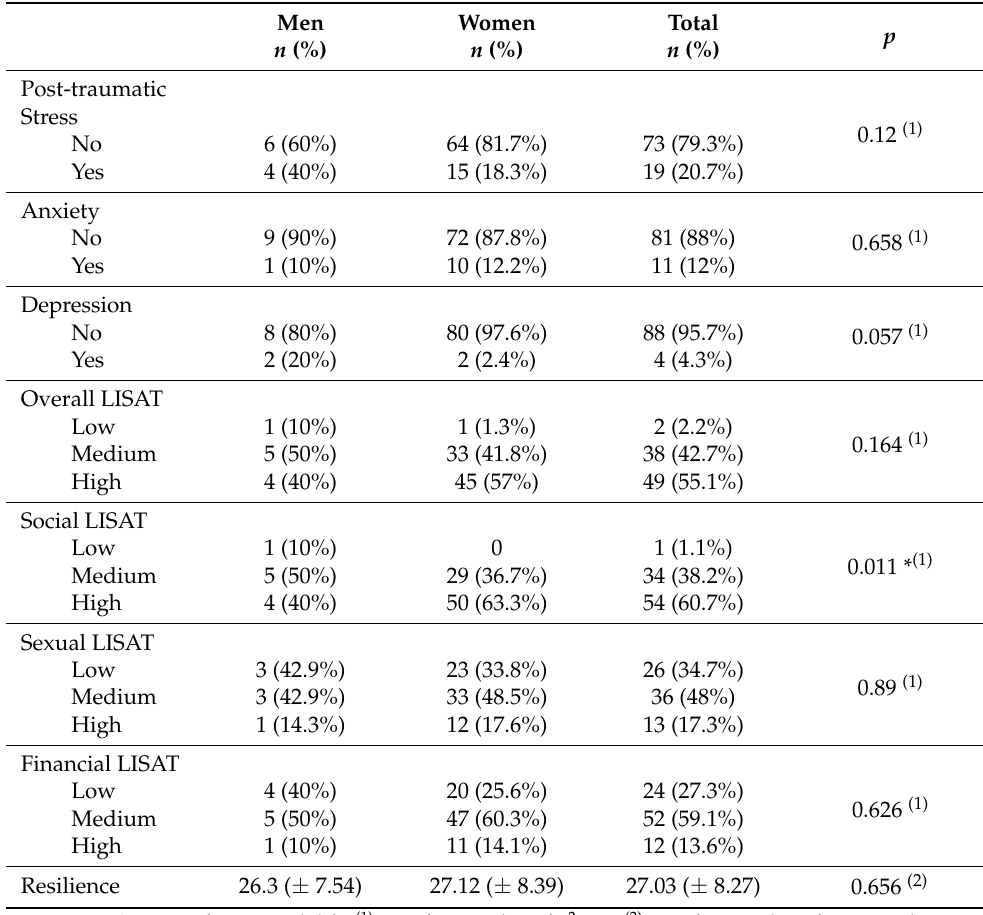
Table 1. Responses to the different scales during the post-test phase (December 2020) (by analyzed total responses and by